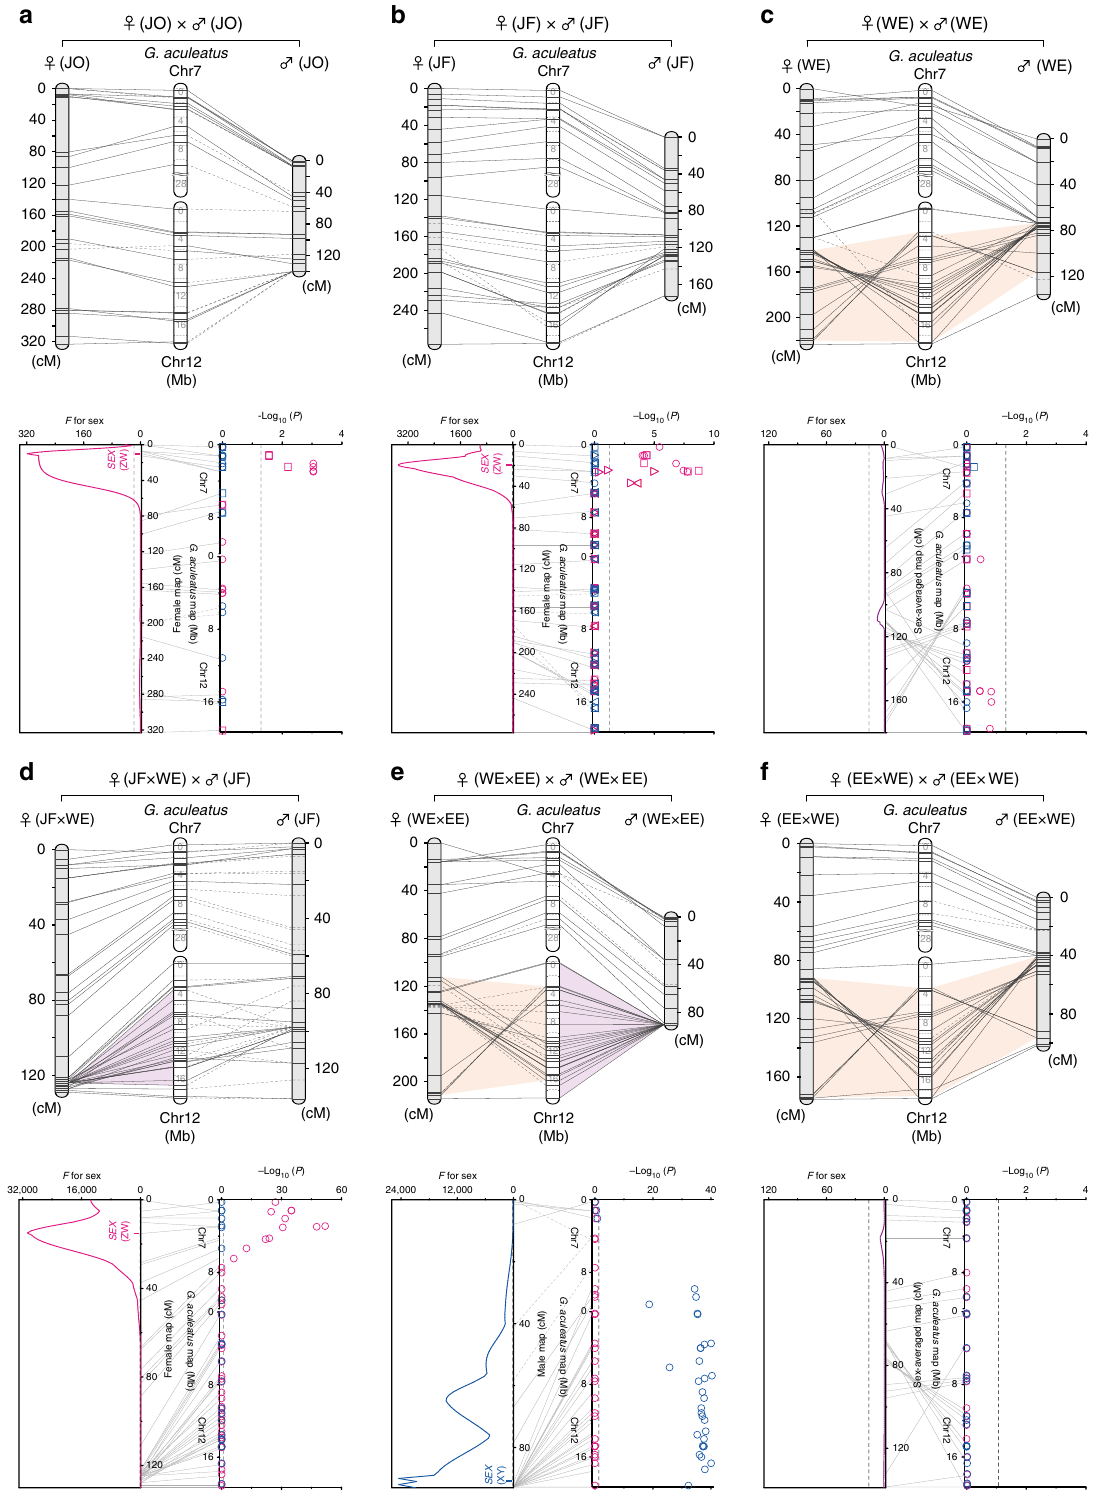
Fig. 2 Comparative genetic maps and sex determination systems. Comparative genetic maps of Pungitius LG12 and G. aculeatus Chr7 and Chr12 in the JO lineage ( a ), the JF lineage ( b ), the WE lineage ( c ), a backcross between an F 1 hybrid female (JF female×WE male) and a JF male ( d ), and F 2 crosses between a WE female and an EE male ( e ) and between an EE female and a WE male ( f ). Female and male maps are shown to the left and right of G. aculeatus physical maps, respectively, on the top. Orange shaded areas indicate large inverted chromosomal regions between Pungitius and G. aculeatus , whereas purple shaded areas indicate non- recombining chromosomal regions. Dashed lines in comparative maps indicate uninformative (i.e., non-segregating) loci in the corresponding sex. QTL positions for sex and signi fi cance levels of associations between sex and loci are shown in the graphs to the left and right at the bottom, respectively. Dashed lines indicate statistically signi fi cant levels ( P = 0.05). The means and 95% con fi dence intervals of QTL positions are indicated to the left of the map positions. In the graphs on the right, maternally and paternally segregating alleles are indicated in red and blue, respectively. Different symbols represent data from different families 4 NATURE COMMUNICATIONS| (2019) 10:145